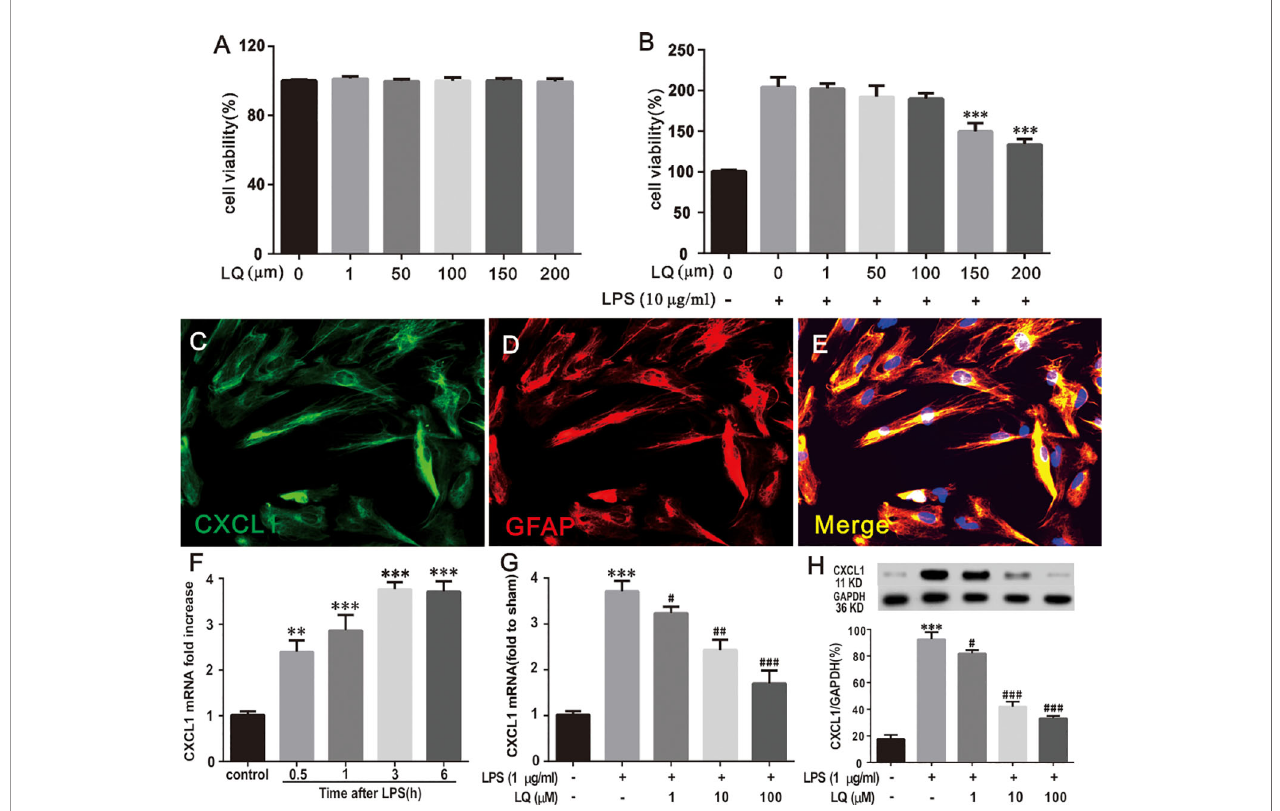
FIGURE 8 | Liquiritin (LQ) reduces LPS-induced mRNA increase of CXCL1 expression in primary cultured astrocytes. (A) Astrocytes were treated with indicated concentrations (1, 50, 100, 150, and 200 m m) of LQ and assessed using MTT assay. The control cells were treated with DMSO (F 5,30 = 0.1567, P > 0.05 vs. control; n = 6, one way ANOVA, A ). (B) LPS stimulated astrocytes were exposed to LQ (1, 50, 100, 150, and 200 m m) and assessed using MTT assay (F 6,35 = 19.61, ***P < 0.001 vs. control; n = 6, one way ANOVA, 8B ). (C – E) Double staining of CXCL1 with GFAP showed the CXCL1 expression by astrocytes. Scale bar = 50 m m (F) LPS (1 m g/ml) dramatically increased CXCL1 mRNA expression in primary astrocytes at 0.5, 1, 3 and 6 h (F 4,15 = 24, **P < 0.01,***P < 0.001 vs. control; n = 4, one way ANOVA, F ). (G, H) LPS-induced CXCL1 upregulation was decreased by treatment with LQ (F 4,15 = 25.2,***P < 0.001 vs. naïve, # P < 0.05, ## P < 0.01, ### P < 0.001 vs. control; F 4,15 = 83.49, ***P < 0.001 vs. naïve, # P < 0.05, ### P < 0.001 vs. control; n = 4, one way ANOVA, 8G, H ). All data are presented as means ±